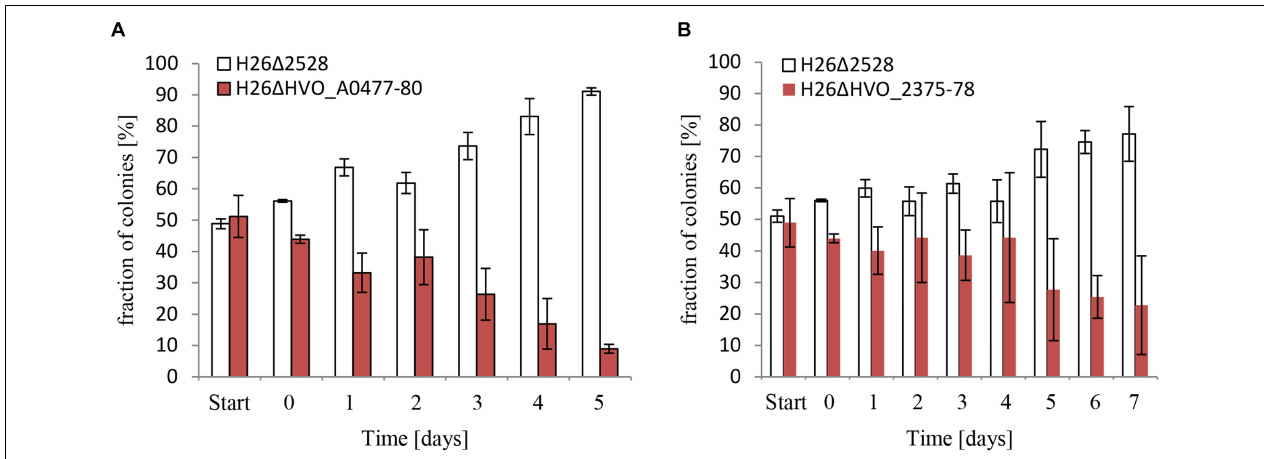
FIGURE 7 | Competitive growth between the wild-type, and respectively, a HVO_A0477-A0480 operon deletion mutant (A) and a HVO_2375-2378 operon deletion mutant (B) . The operon deletion mutants had the normal red color of H. volcanii . The operon wild-types were white due to the deletion of the carotenoid- biosynthesis gene HVO_2528. For comparative growth analysis two strains were grown to mid-exponential phase and mixed to equal rations. The mixture was grown overnight, with very reduced phosphate concentrations of 10 µ M (A) and 50 µ M (B) , instead of the normal concentration of 1 mM. Aliquots were taken and dilutions were plated to enable quantification of the numbers of red and white colonies. The overnight culture was also used to inoculate a fresh culture, and this procedure was repeated for 5 and 7 days, respectively. The fractions of red and white colonies are shown.